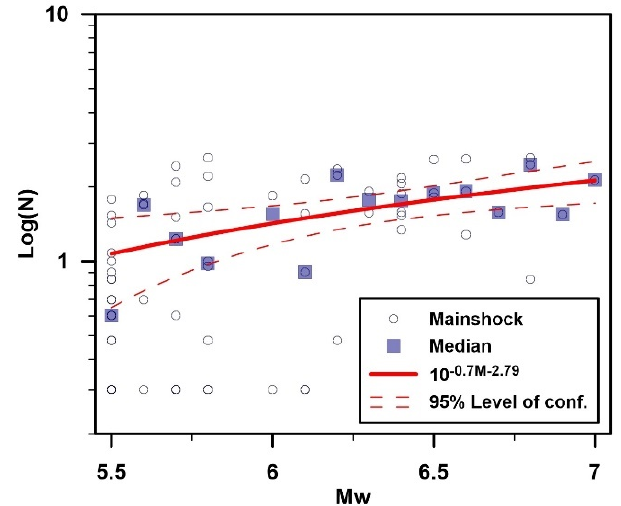
Figure 3. Logarithm of the number of aftershocks of mainshocks with M w ≥ 5.5 for 60 days after the mainshock occurrence for seismic sequences that occurred between 1995 and 2021. The productivity law is fitted through linear least squares regression using the median log number of aftershocks for each 0.1 magnitude bin.